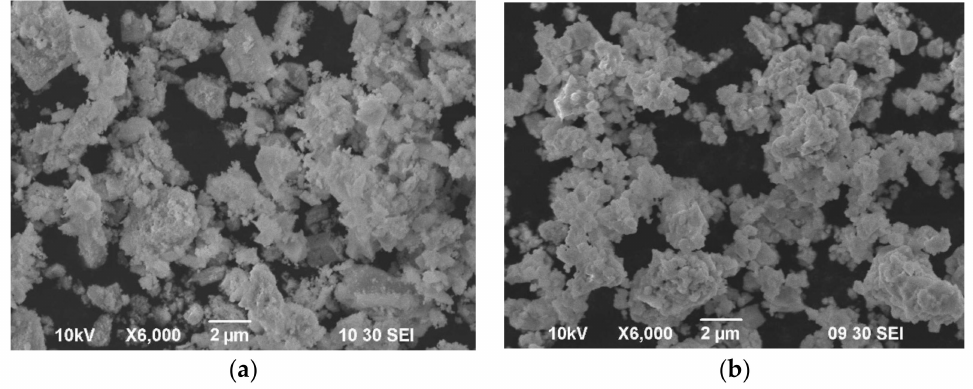
Figure 2. Morphology of as-prepared powders: ( a ) SDC (T calc = 900 ◦ C); ( b ) BCZYYbO (T calc = 1100 ◦